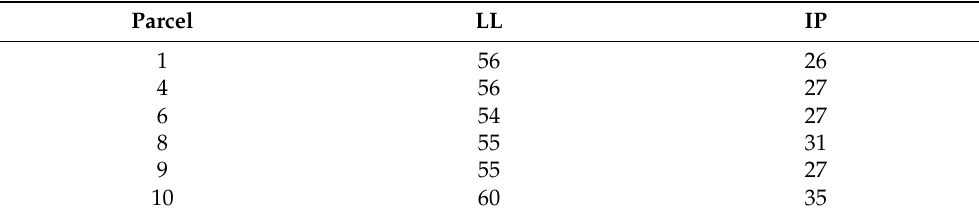
Table 8. Atterberg limits in field